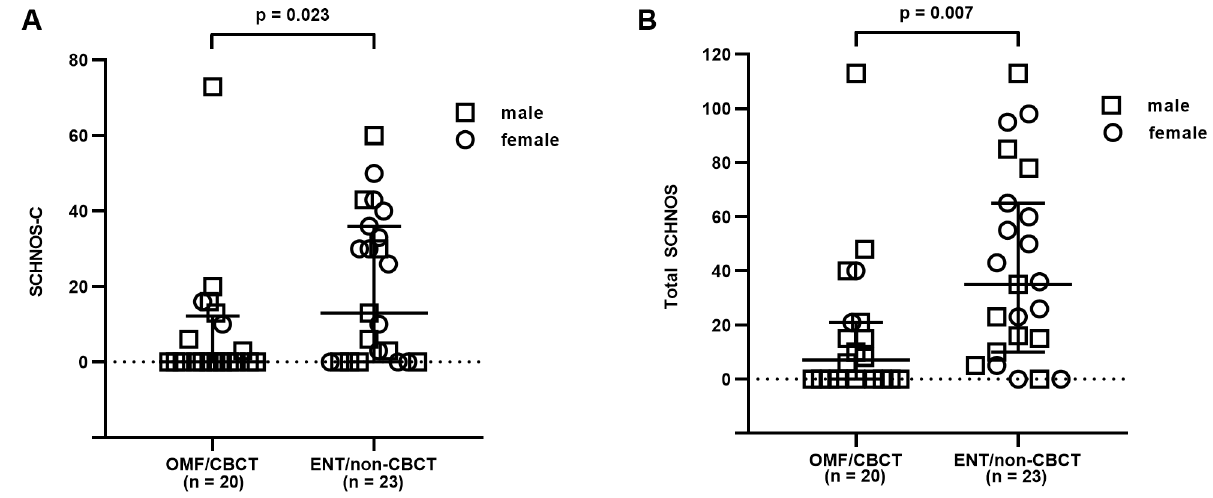
Figure 2. Comparison of SCHNOS-C (A) and total SCHNOS (B) between patients of the OMF/CBCT group and patients of the ENT/non-CBCT group.